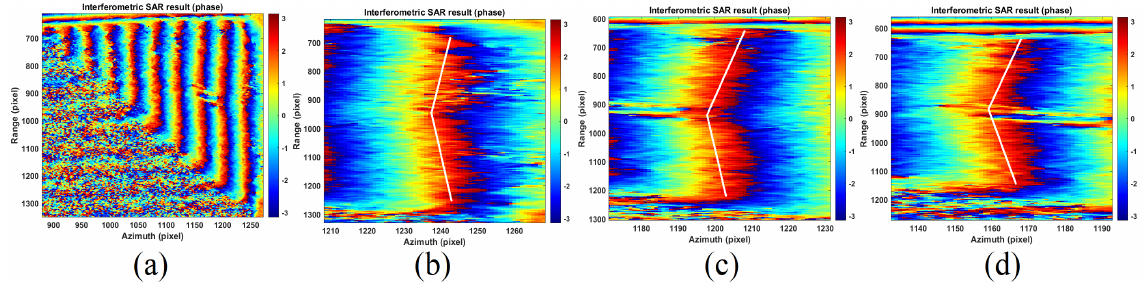
Figure 14. Representation in particular of the pyramid of Khnum-Khufu. Interferometric phases. ( a ): north side. ( b – d ): magnification of interferometric fringe 1, 2, and 3.